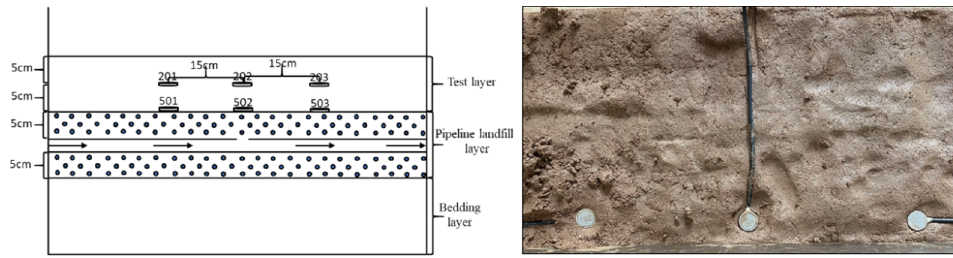
Figure 3. Arrangement of monitoring points.